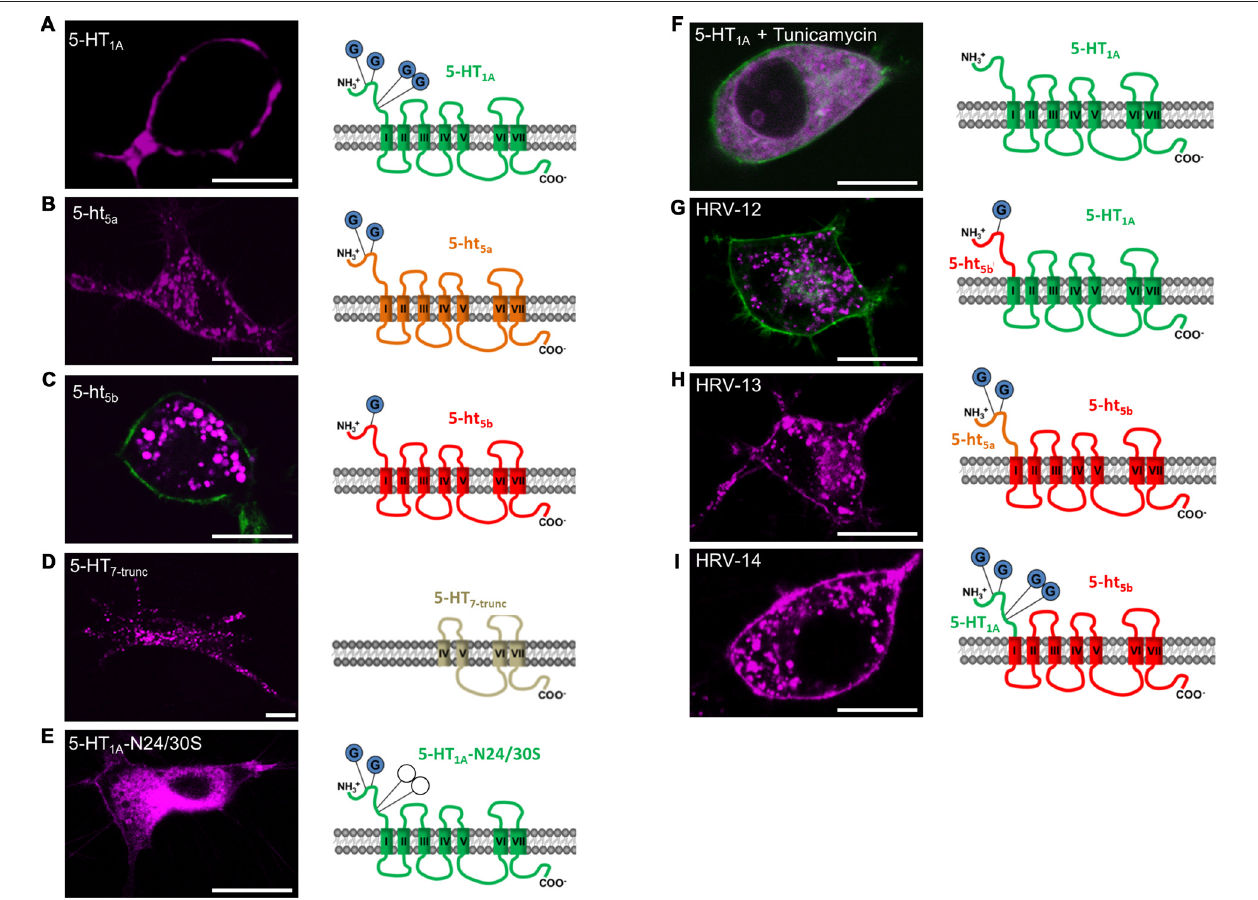
FIGURE 2 | Effect of N-terminal glycosylation on membrane trafficking of 5-HT receptors. For all experiments, N1E-115 cells were transiently transfected with the same amount of receptor corresponding deoxyribonucleic acid (cDNA). All receptor constructs are shown in purple. If the outline of the cell was not easily recognized, a membrane label (GAP-43) was co-transfected (green). (A) 5-HT 1A possesses four glycosylation sites on the N-terminus and displays specific membrane localization. (B) 5-ht 5a possesses only two glycosylation sites. In comparison to the other 5-HT receptors, 5-ht 5a shows weak membrane staining, but pronounced staining of endosomal compartments. (C) 5-ht 5b possesses only one glycosylation site and membrane localization of the receptor is not detectable. (D) Artificially truncated 5-HT receptor 5-HT7 (5-HT7-trunc) comprises the trans-membrane domains (TMDs) IV to VII and shows strong intracellular clustering with no discernable membrane staining. (E) Site-directed mutagenesis of Asparagine (N) to Serine (S) at positions 24 and 30 in 5-HT 1A -N24/30S removes two of four glycosylation sites and greatly reduces membrane trafficking of the mutated receptor. (F) Tunicamycin blocks the formation of protein N-glycosidic linkages by inhibiting the transfer of N-acetylglycosamine-1-phosphate to dilichol mono-phosphate. Application of Tunicamycin (1 µ g/ml) to cells expressing 5-HT 1A removes the receptor from the cell membrane. (G) Replacing the N-terminal domain of 5-HT 1A containing 4 glycosylation sites with the N-terminal domain of 5-ht 5b with 1 glycosylation site